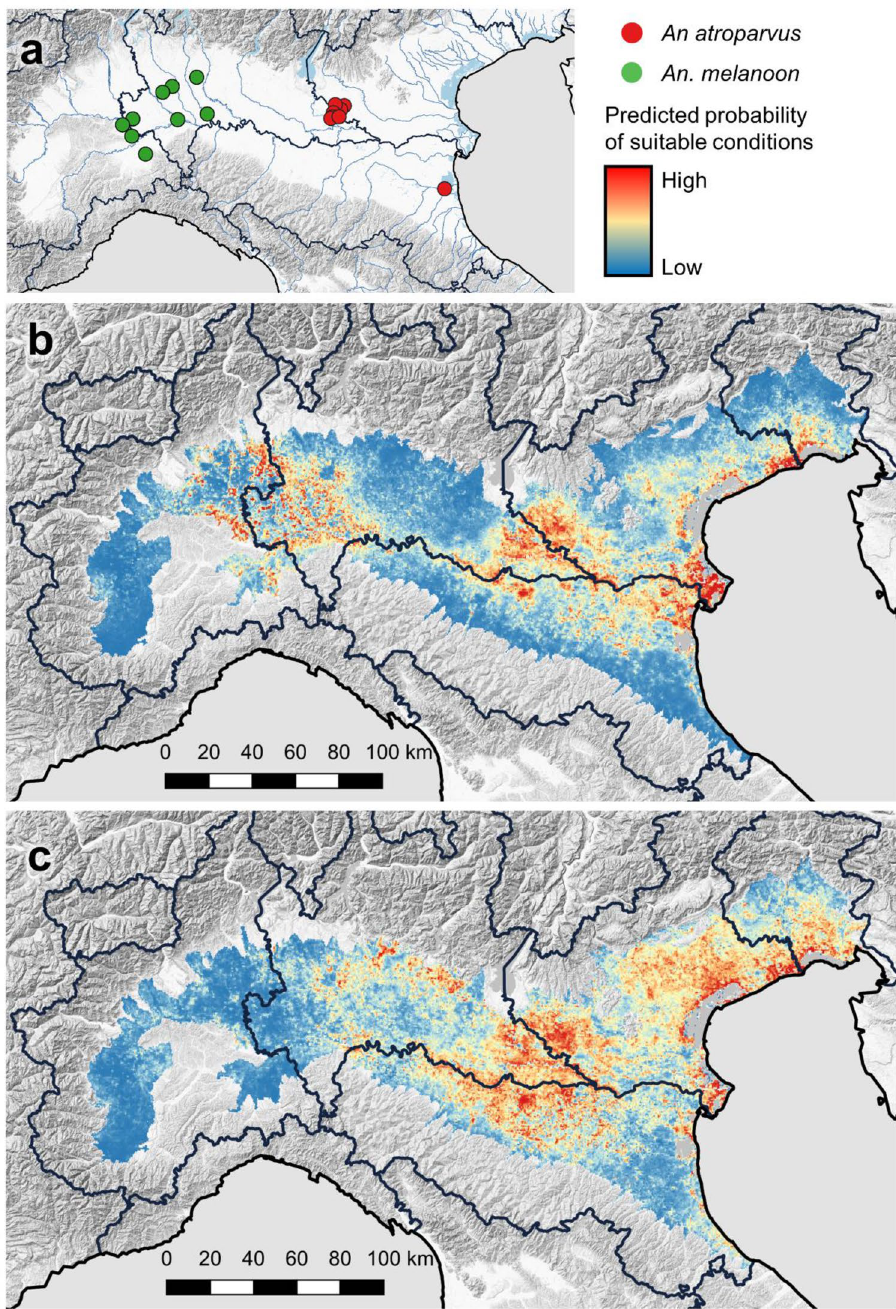
Figure 4. ( a ) Site of detection of An. atroparvus (red) and An. melanoon (green). Output of ENM obtained by Maxent for An. daciae sp. inq. ( b ) and An. maculipennis s.s. ( c ). Map created using QGIS 3.10 (www. qgis. org); raster layers: Globe DEM (www. ngdc. noaa. gov), EU-Hydro (www. coper nicus.